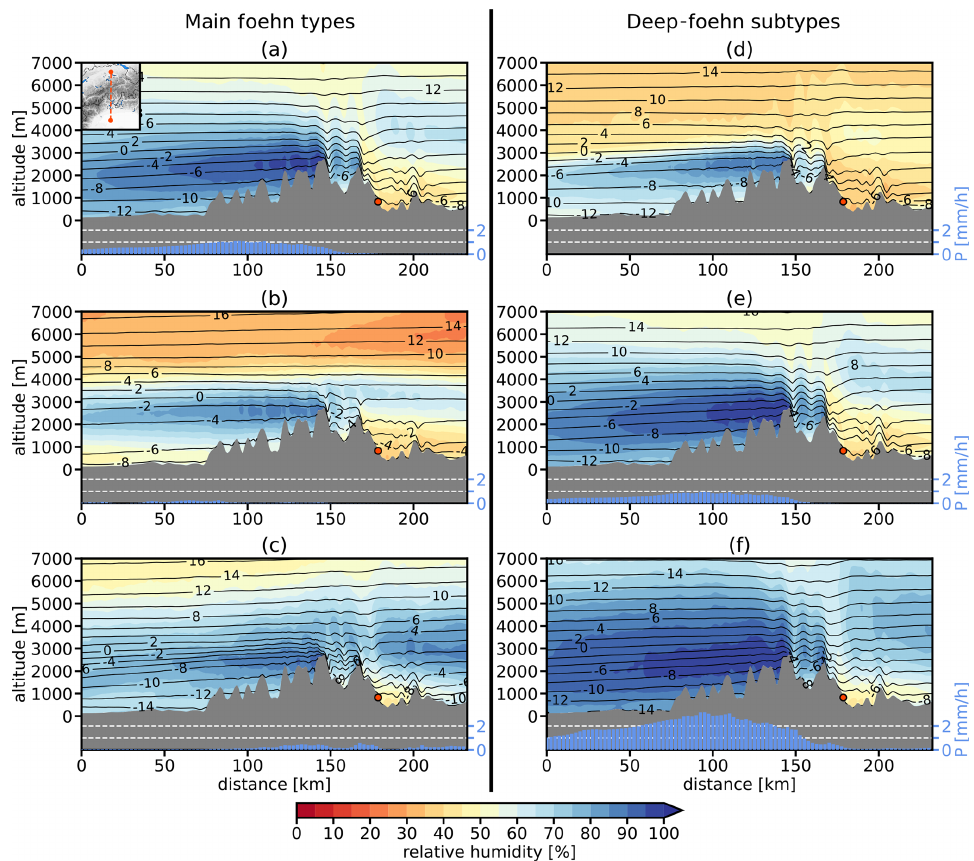
Figure 4. Alpine-crossing composites of relative humidity (colour) and normalized potential temperature (black contours) in vertical cross sections based on the COSMO-1 analysis. Precipitation along the cross section is indicated as blue bars, and the cross-section path is displayed as a red line in the inset in the upper left of the first panel. (a) Deep foehn; (b) shallow foehn; (c) gegenstrom foehn; (d) dry foehn; (e) moist foehn; (f) dimmer foehn. The latitudinal position closest to Altdorf is marked as a red